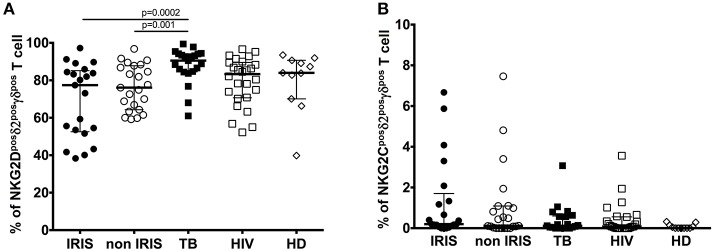
NKG2D, and NKG2C expression on δ2posγδpos T cell in TB-IRIS and non-IRIS at baseline. The proportion of NKG2Dposδ2posγδpos T cell (A), NKG2Cposδ2posγδpos T cell (B) in TB-IRIS, non-IRIS, and control groups [TB (TB+/HIV–), HIV (HIV+/TB–), and HD (HIV–/TB–)] are shown. The results are median and 25–75% interquartile range. Significant p-values (p < 0.05) are denoted.